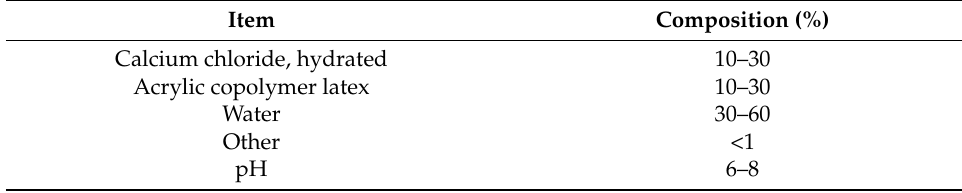
Table 1. Chemical composition of the CaCl 2 -blended acrylic polymer emulsion.